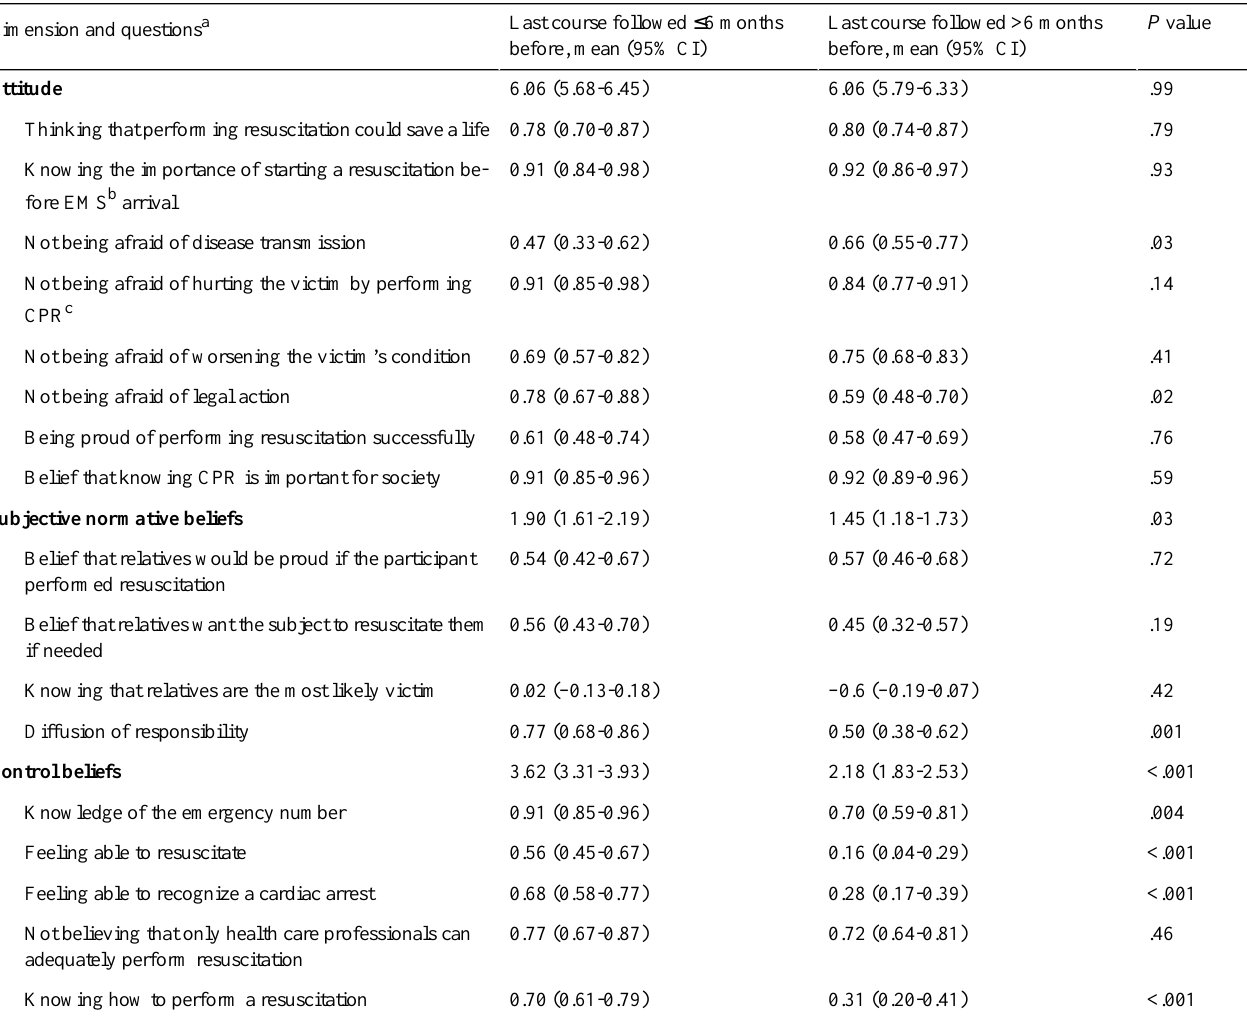
Table 2. Univariate analysis of the three dimensions of the intention to perform resuscitation in first-aid course participants (N=204).